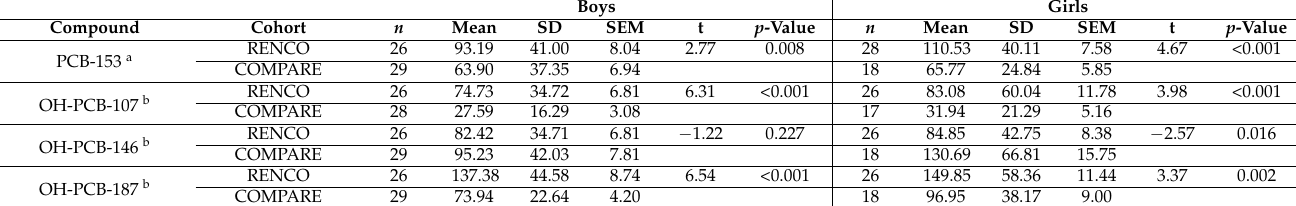
Table 2. T -tests comparing means of prenatal levels of PCB-153 and OH-PCBs between the RENCO and COMPARE cohorts for children included in the DACE study.